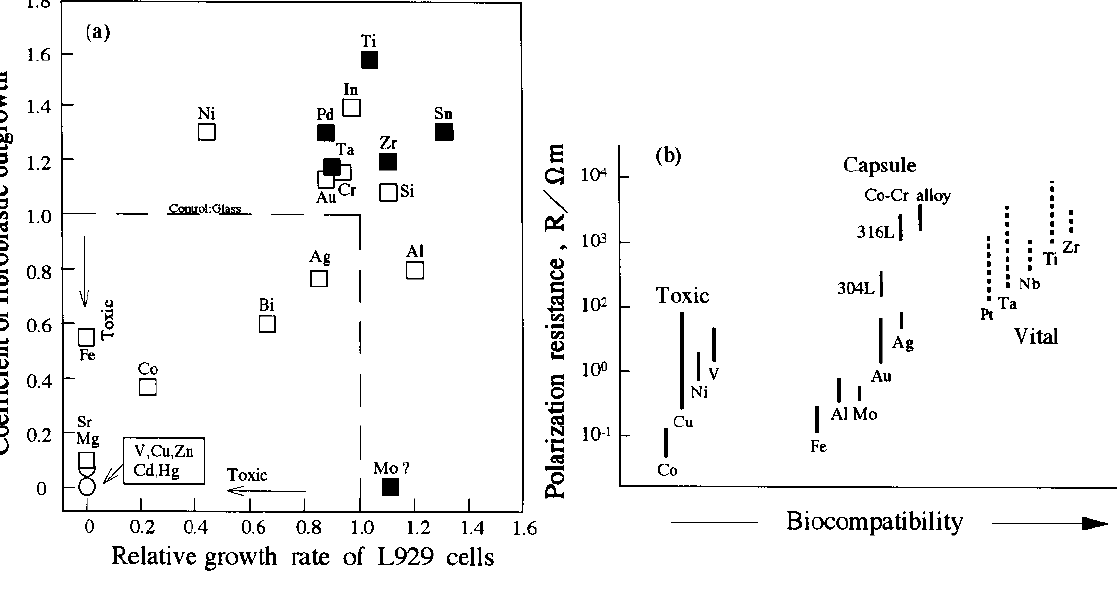
Figure 3. Biological safety of metals ( a ) cytotoxicity of pure metals; and ( b ) relationship between polarization resistance and biocompatibility of pure metals, Co-Cr alloy and stainless steels [18]. Reprinted with permission from [18]. Copyright 1998